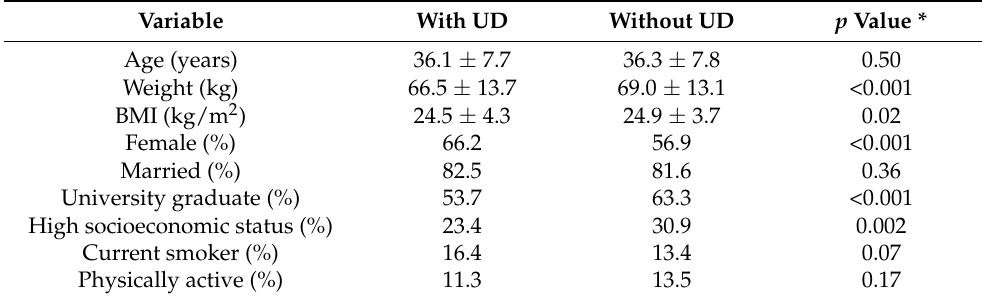
Table 1. General characteristics of the study